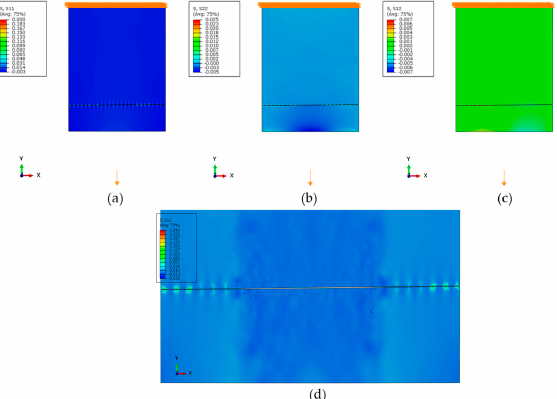
Figure 8. Optimization evolution of best and mean value for parameter 𝑑 The stresses field for the optimum case, where the blank distance, 𝑑 , and angle, α , were optimized, are presented in Figure 9, in the increment just before rupture.